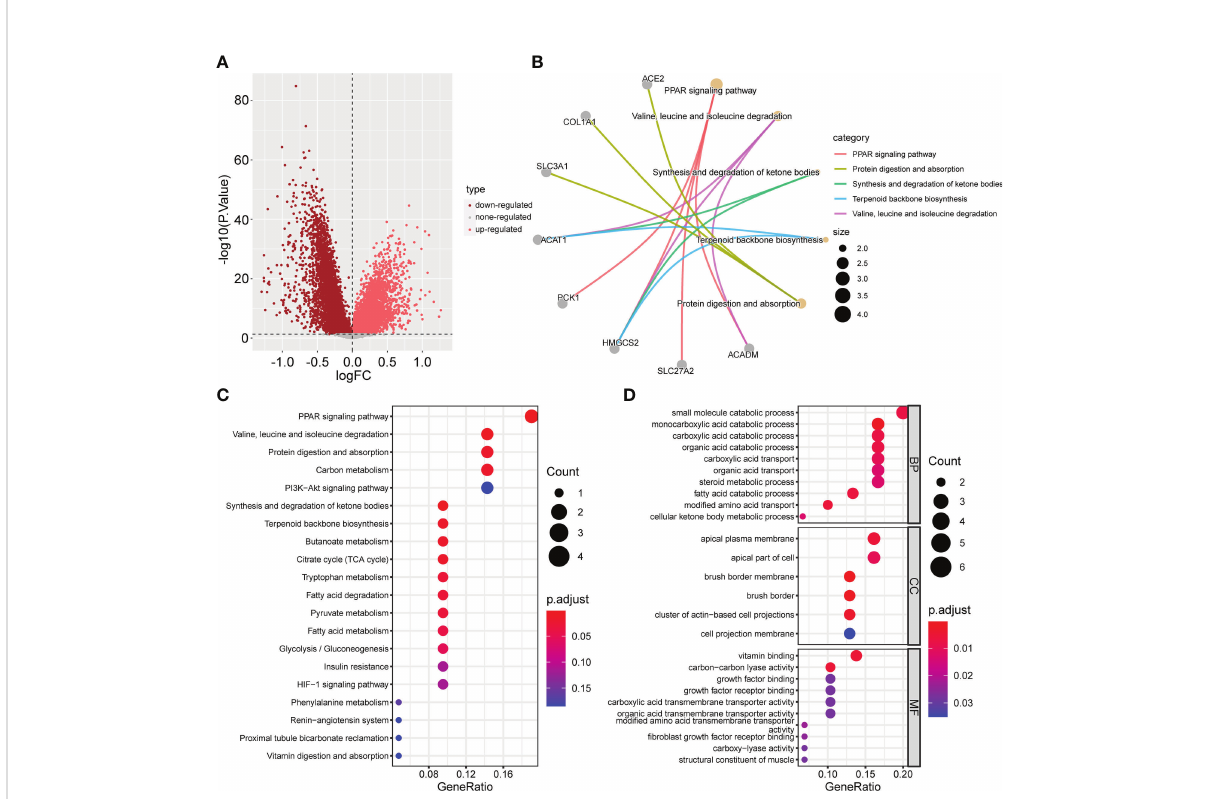
FIGURE 5 Screening and enrichment analysis of DEGs between the two CPG subtypes. (A) Volcano plot about Difference analysis between the two CPG subtypes. (B) The network diagram shows the correspondence between the KEGG top fi ve pathways and related genes. (C) KEGG enrichment analysis of DEGs among two CPG subtypes. (D) GO enrichment analysis of DEGs among two CPG subtypes. DEG, differentially expressed gene; CPG, cuproptosis-promoting